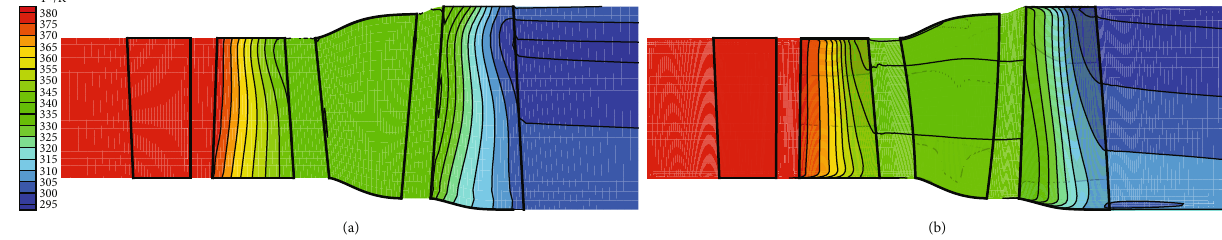
Figure 11: Total temperature of the two-stage turbine: (a) Q3D; (b)